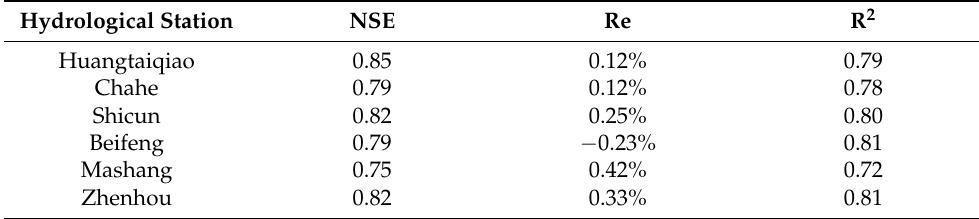
Table 3. Simulation effect evaluation of cross-section discharge in Xiaoqing River Basin.